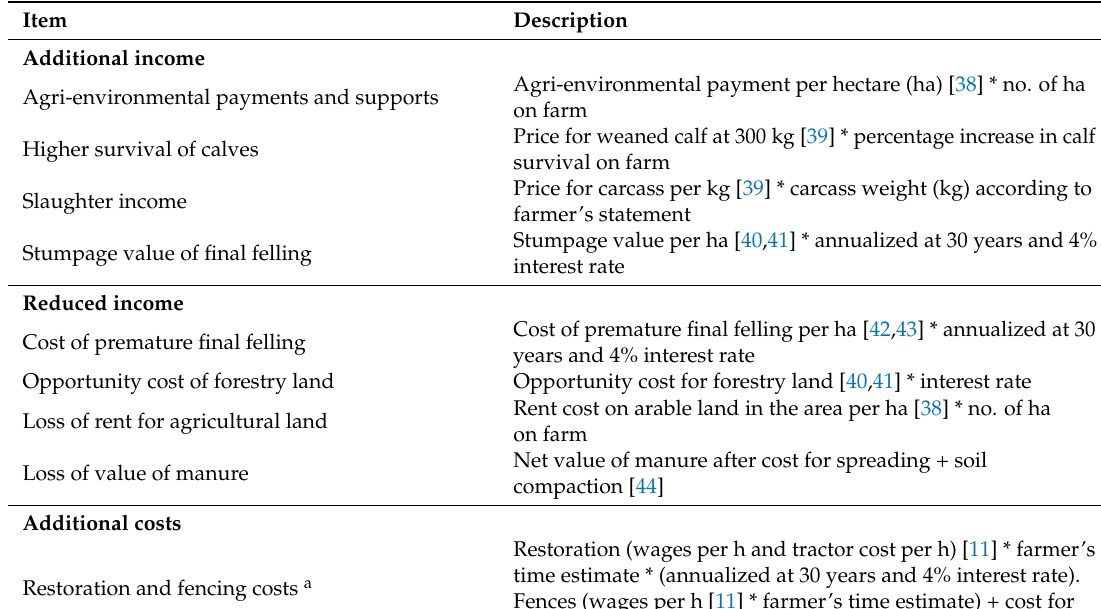
Table 2. Descriptions and calculations of items when creating large coherent pasturelands from small scattered pastures in five Swedish cow-calf